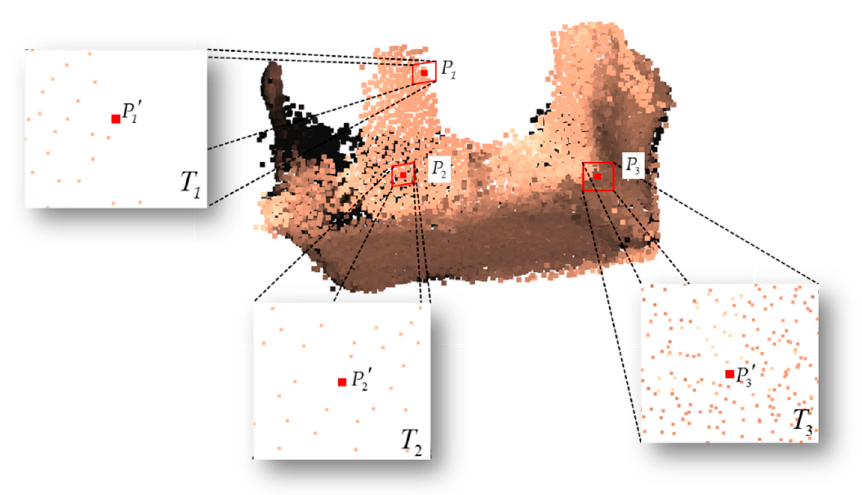
T and T are Figure 3. Example of projecting the neighborhood points to the tangent plane: T 1 , T 2 and T 3 are the , 2 3 1